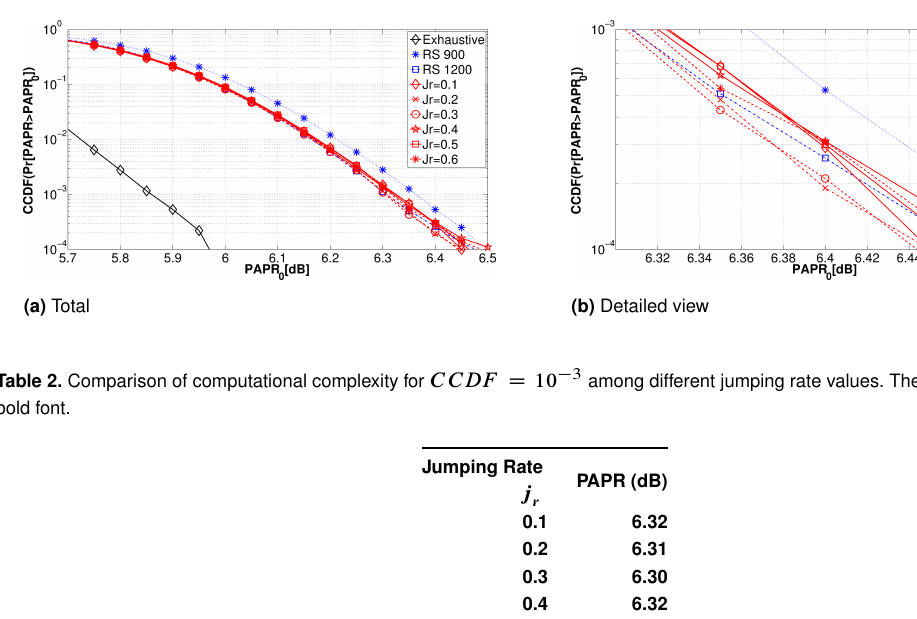
Fig. 4. PARP reduction performance comparison of GOBBO-PTS algorithm with different jumping rate values.